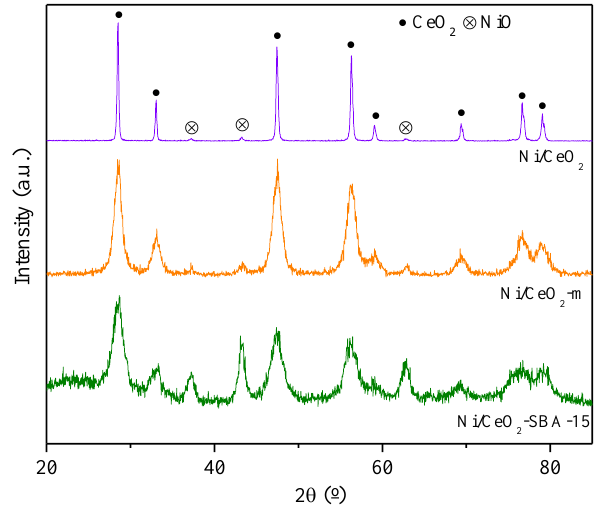
Figure 3. XRD patterns of calcined Ni-based catalysts.